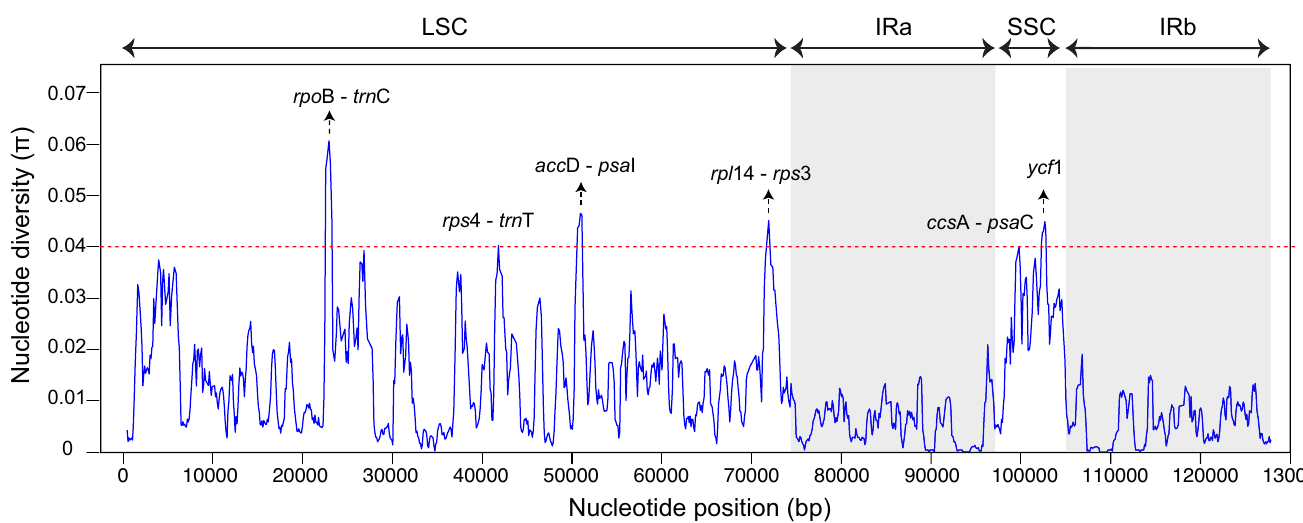
Fig 3. Nucleotide variability in 29 Taxillus plastomes. Sequence diversity was calculated using a sliding window analysis (window size = 500 bp, step size = 100 bp). The six most variable regions are labeled.